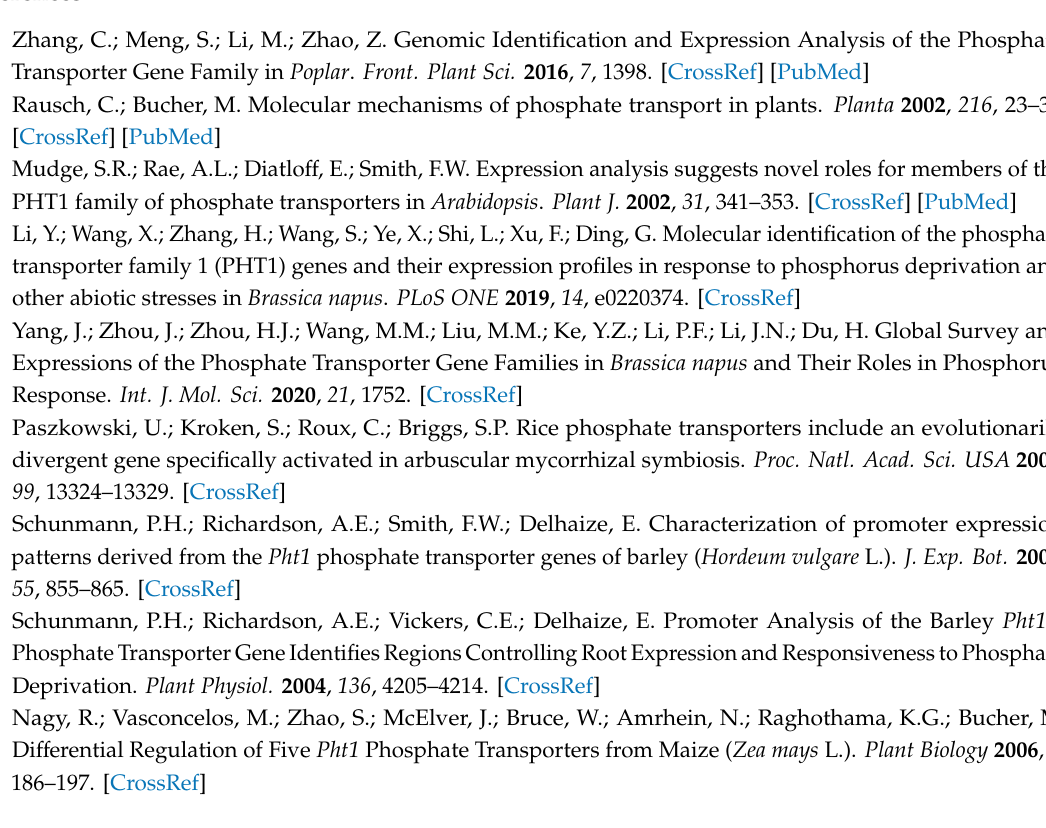
s1. Table S1. List of PHT genes identified in the A. thaliana and Brassica genomes; Table S2. One-to-one orthologous relationships between A. thaliana and other five plant species; Table S3. B. napus ZS11 tissues and organs used in this study; Table S4. The FPKM values of PHT family genes in B . napus by RNA-Seq analysis; Table S5. The relative expression values of PHT family genes in B. napus by RNA-Seq analysis under As 3 + and Cd 2 + treatment; Table S6. Primers used to amplify the PHT genes and reference genes using qRT-PCR; Figure S1. Collinearity analysis of PHT family genes among Arabidopsis and five Brassica species; Figure S2. The detailed information of motif logos are obtained from the MEME Suite website; Figure S3. The phenotypes of rapeseed under As 3 + and Cd 2 + stress. Author Contributions: C.Q. (Cunmin Qu) and K.L. conceived and designed the experiments; Y.W. and Z.W. conducted the experiments; J.X., S.S., and M.G. collected and analyzed the data; M.Z., C.Q. (Cailin Qiao), and F.S. carried out the experiments and performed software; Y.W., K.L., and C.Q. (Cunmin Qu) wrote the manuscript;